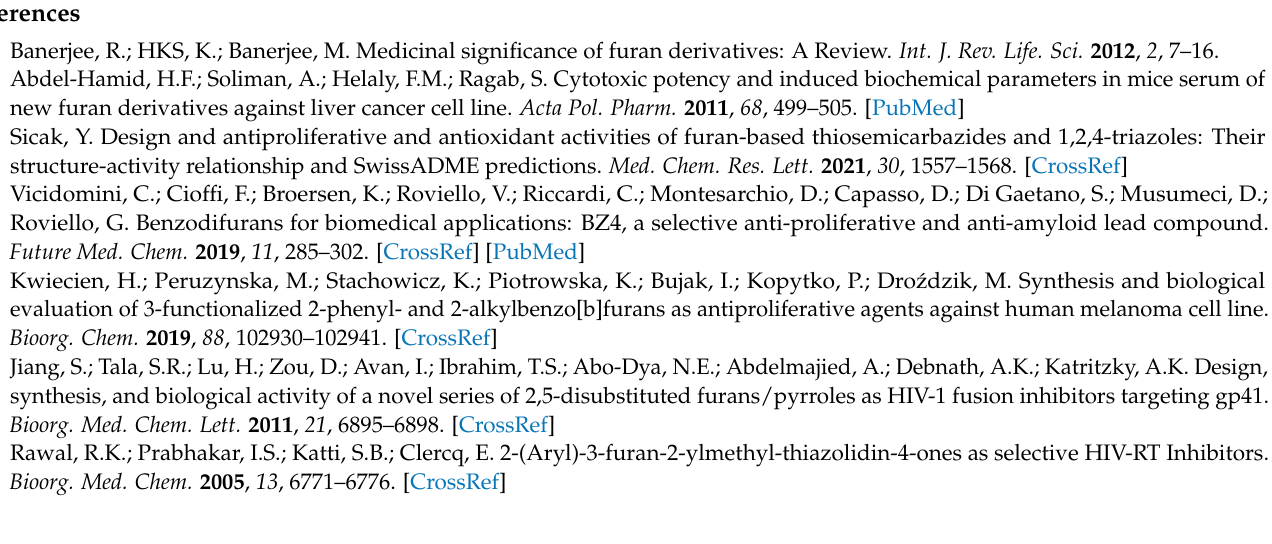
compound 9a ; Figure S2. NOESY spectrum of compound 9a & 1 H NMR spectrum of compound 9b ; Figure S3. 1 H & 13 C NMR spectrum of compound 9c ; Figure S4. 1 H & 13 C NMR spectrum of compound 9d ; Figure S5. 1 H & 13 C NMR spectrum of compound 9e ; Figure S6. 1 H & 13 C NMR spectrum of compound